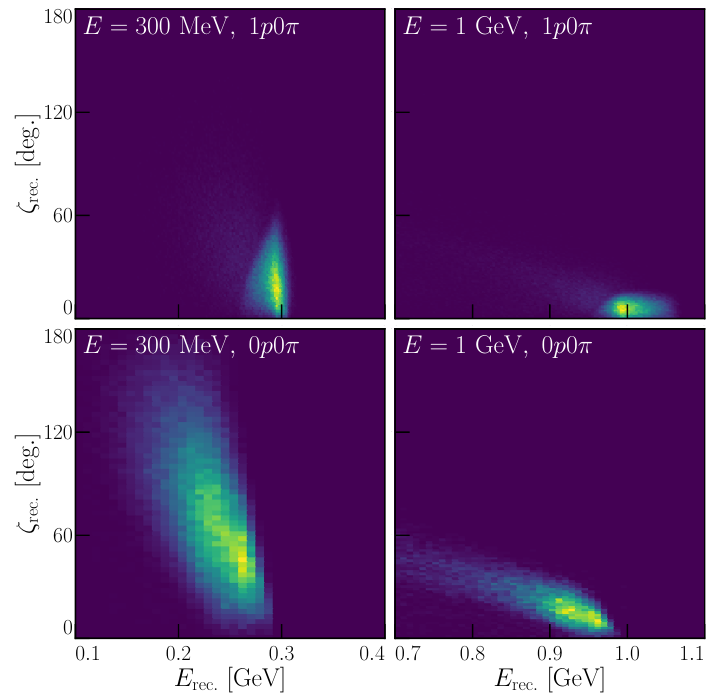
Figure 9 . Reconstructed energy and direction of neutrinos with 300 MeV (left) or 1 GeV (right) energy, where the top (bottom) row corresponds to final states with one (no) visible proton(s). Yellow regions correspond to where more events will be reconstructed, where purple correspond to fewer events. Note that the angular (y-axis) scale is identical in all four panels, whereas the energy (x-axis) scale changes from the left to right